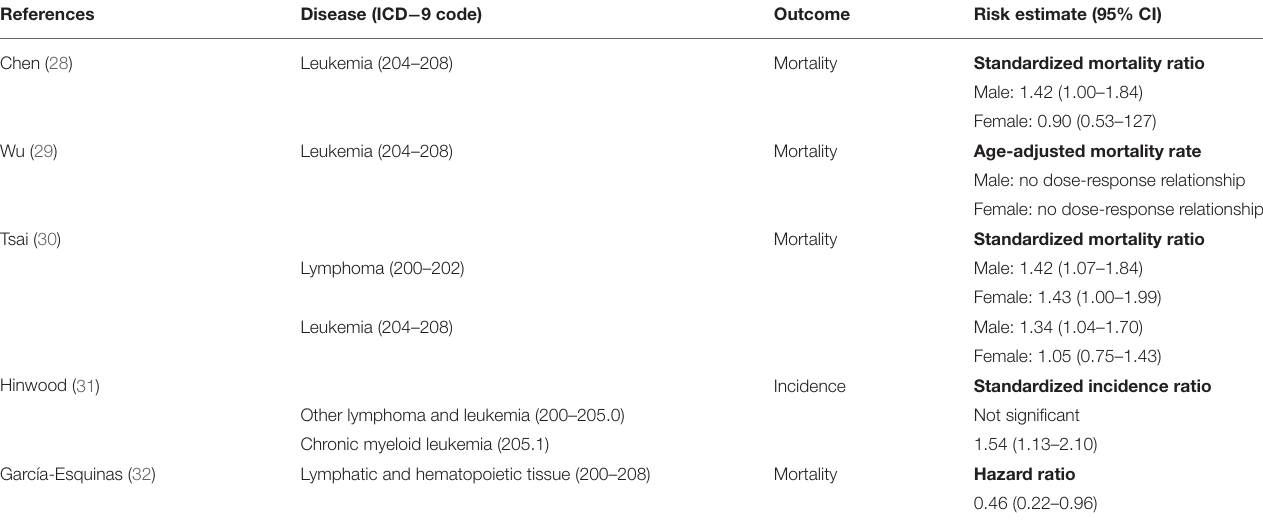
TABLE 3 | Previous studies of the association between arsenic in drinking water and hematologic